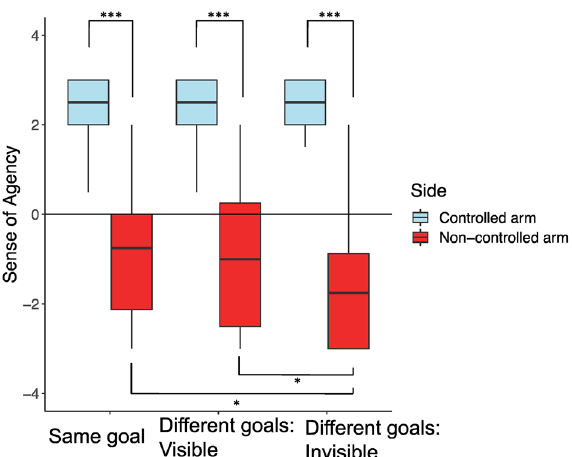
Figure 5. Sense of agency towards the controlled and non-controlled arms of the joint avatar in same goal, different goals: visible and different goals: invisible conditions. The agency towards the non-controlled arm in the same goal and different goals: visible conditions were significantly higher than the agency towards the non- controlled arm in the different goals: invisible condition. In all three conditions, the agency scores towards the controlled arm were significantly higher than the agency scores towards the non-controlled